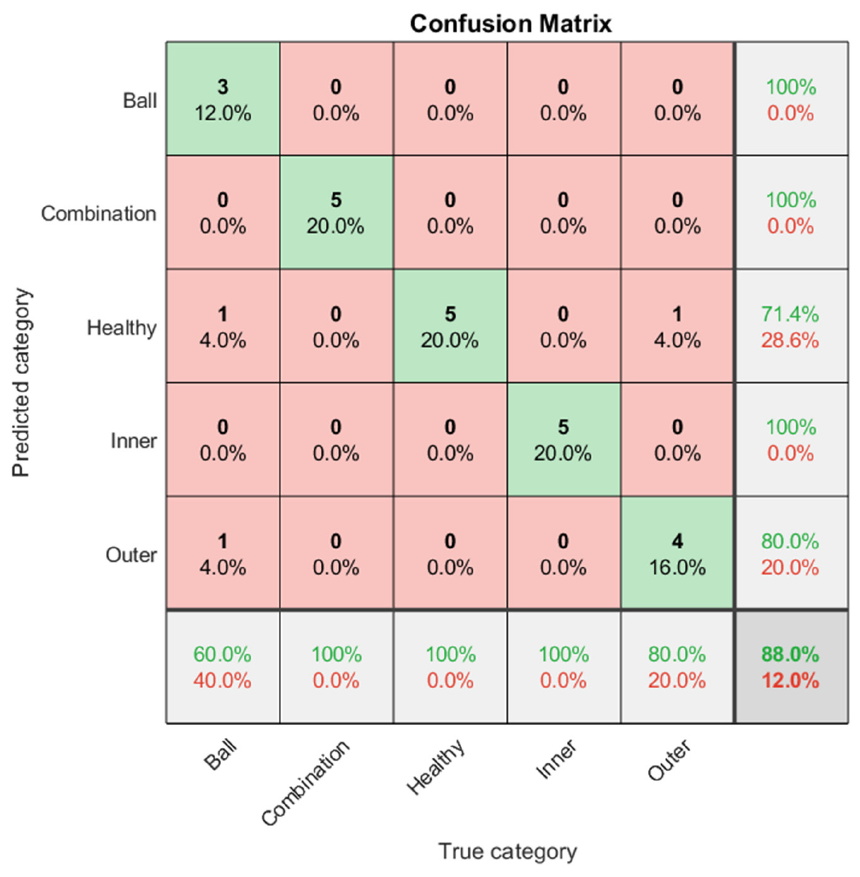
Figure 15. ShuffleNet classification results in confusion matrix; the accuracy rate is 88%.